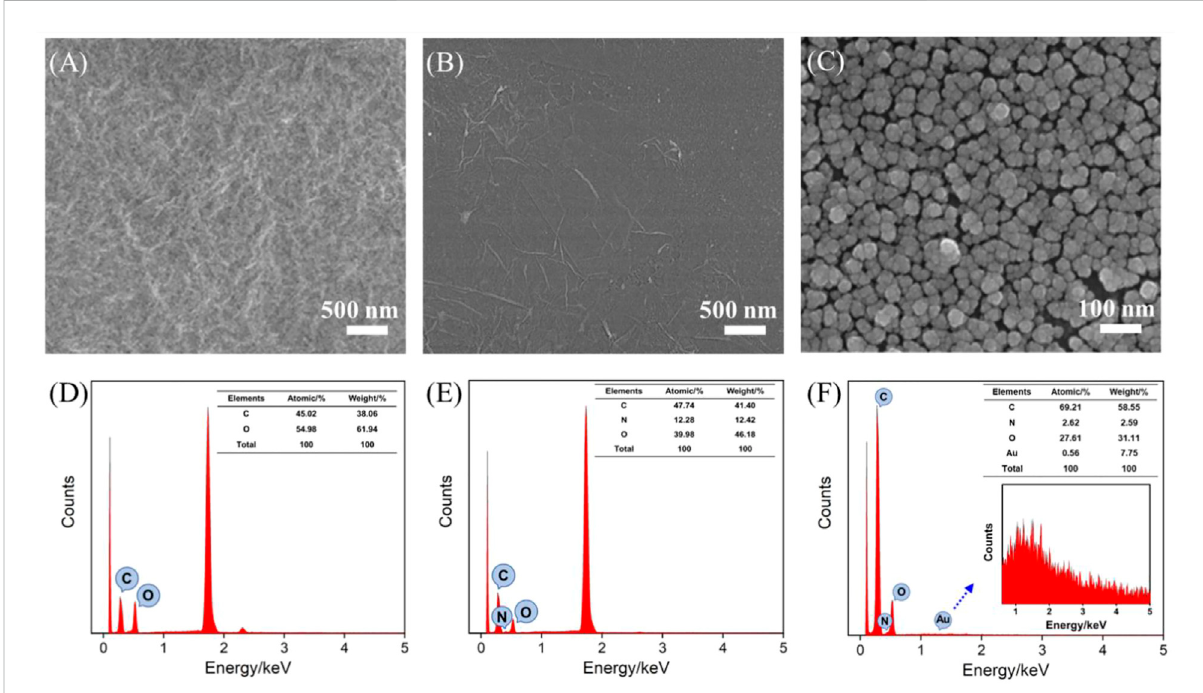
SEMimageofGsynthesizedwithouttheprotectionofCS (A) ,CS-G (B) ,andAuNPs/CS-G (C) modi fi edglassycarbonsheet.EDSofGO (D) ,CS-G (E) , and AuNPs/CS-G (F) . Inset in (F) is the magni fi ed EDS of the Au section.